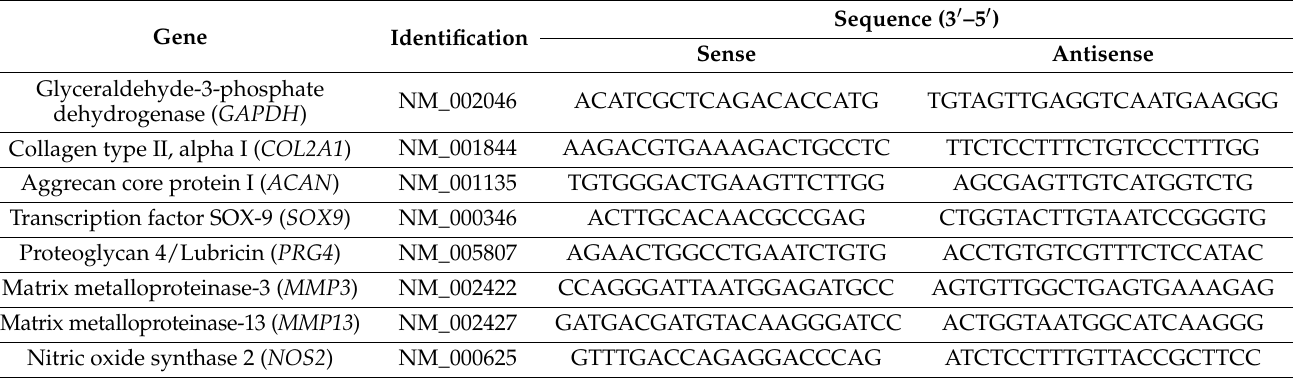
Table 2. Sequences of Primers used in